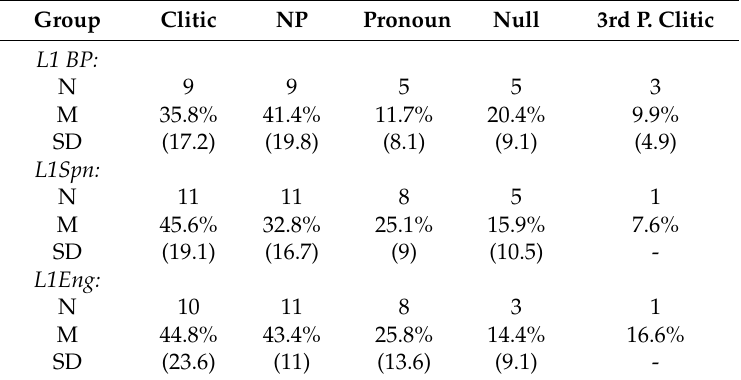
Table 2. Mean percentage distribution (M) of type of object per group. Group Clitic NP